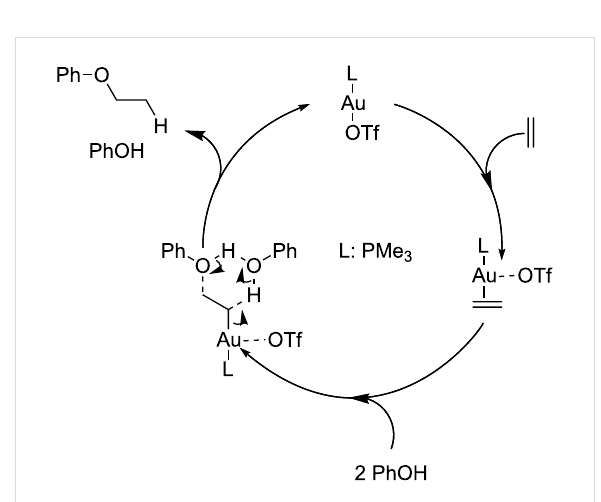
Figure 3: Computed mechanistic cycle for the gold-catalyzed alkoxyla- tion of ethylene with PhOH.